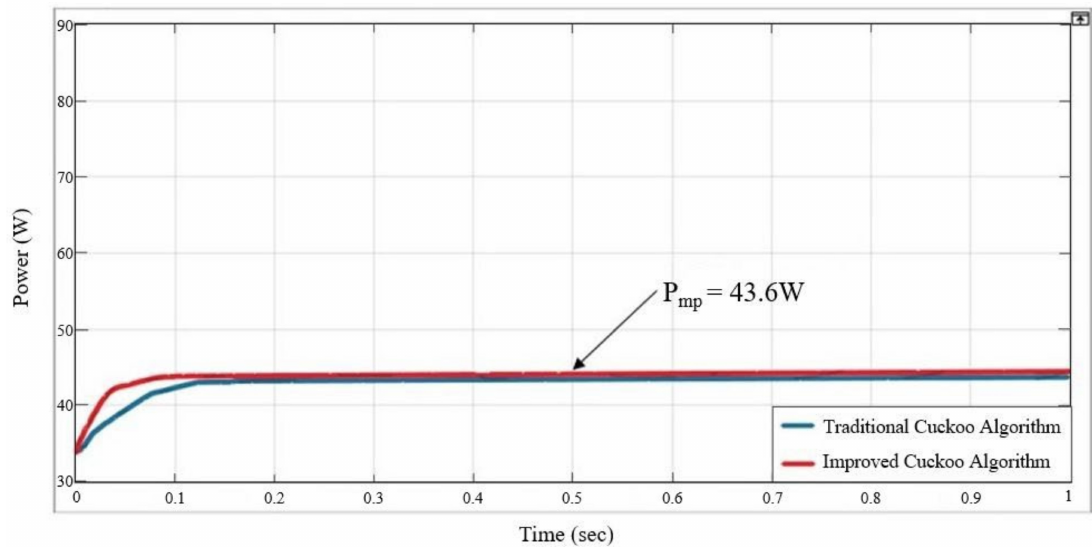
Figure 15. Simulation result of maximum power point tracking of traditional and improved cuckoo algorithm in Case